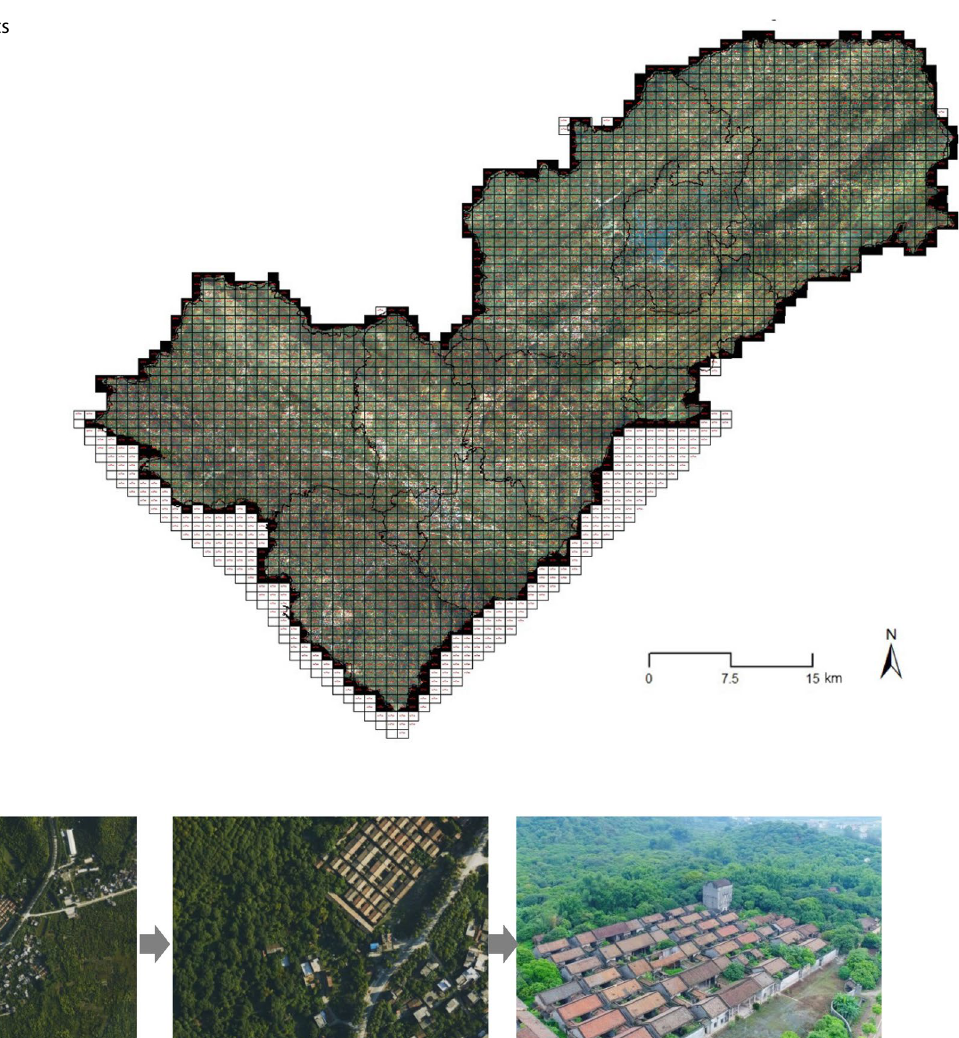
Fig. 2 Study area image and its framing